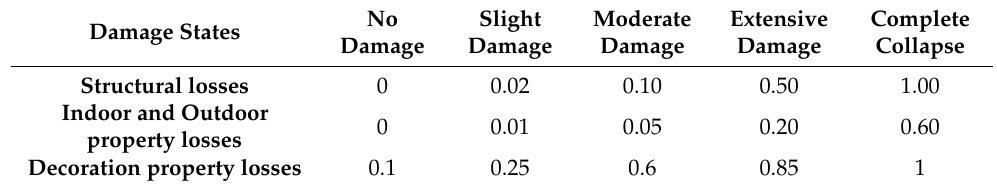
Table 2. Direct loss ratio.